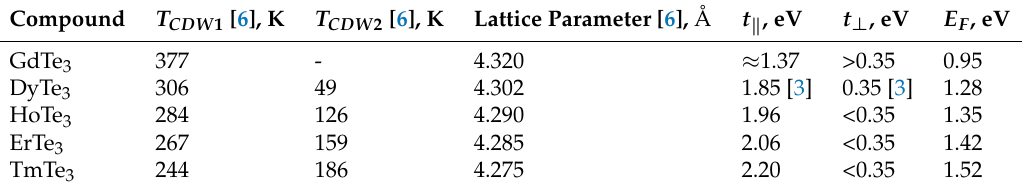
Table 1. List of parameters describing the dispersion and the CDW transition temperatures T CDW 2 and T CDW 2 for rare-earth elements (R) Gd, Dy, Ho, Er, and Tm. Compound T CDW 1 [6], K T CDW 2 [6], K Lattice Parameter [6], Å t (cid:107) , eV t ⊥ , eV E F , eV GdTe 3 377 - 4.320 ≈ 1.37 >0.35 0.95 DyTe 3 306 HoTe 3